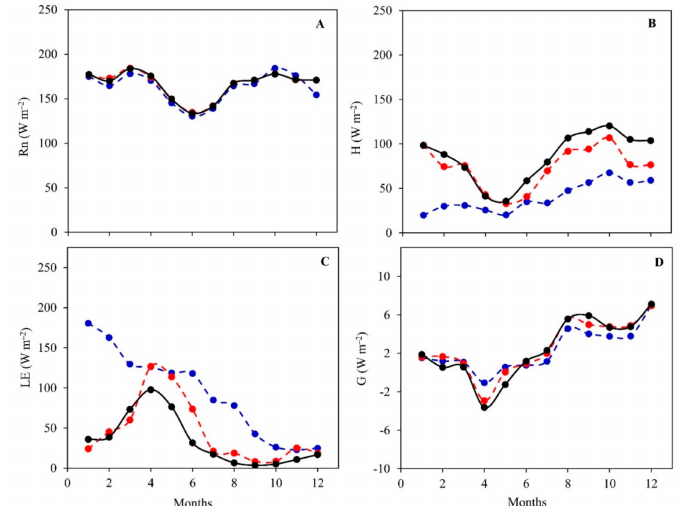
Figure 5. Simulations without calibration (dashed blue lines), simulations with calibration (dashed red lines) for the wet season (simulation V) and dry season (simulation U) and eddy covariance observations (solid black lines) of monthly mean values of energy fluxes of 2014. Net radiation (Rn; ( A )), sensible heat flux (H; ( B )), latent heat flux (LE; ( C )) and soil heat flux (G, ( D )). For details on the calibrated parameters of simulations V and U, see Table